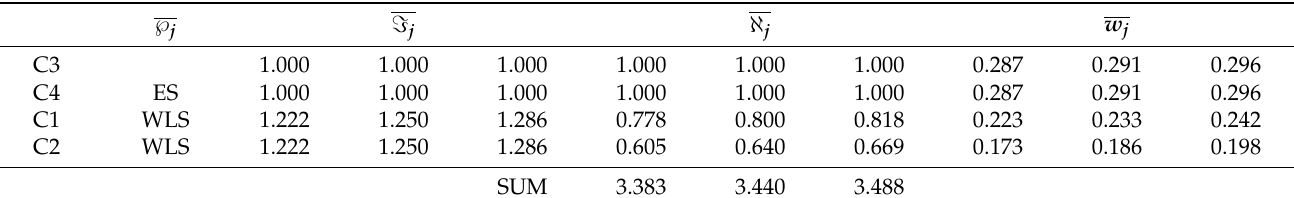
Table 4. Weight values of the criteria calculated with the IMF SWARA